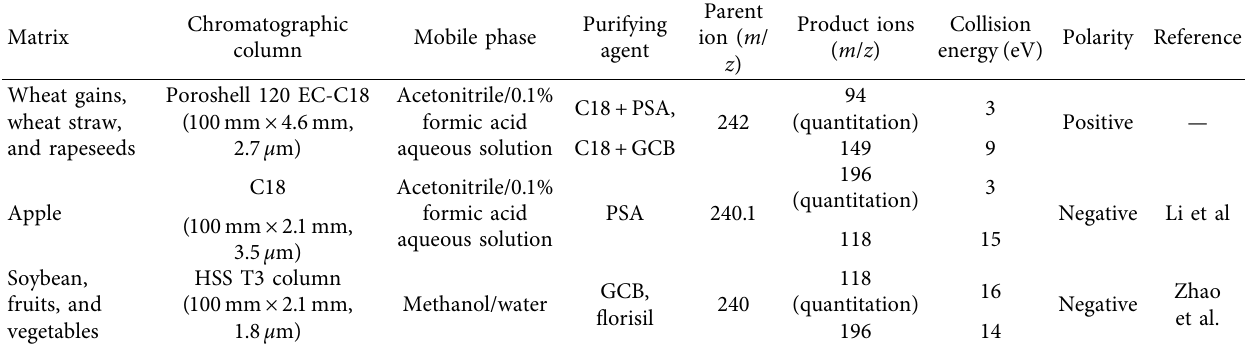
Table 1: Summary of detection conditions for phthalanilic acid.